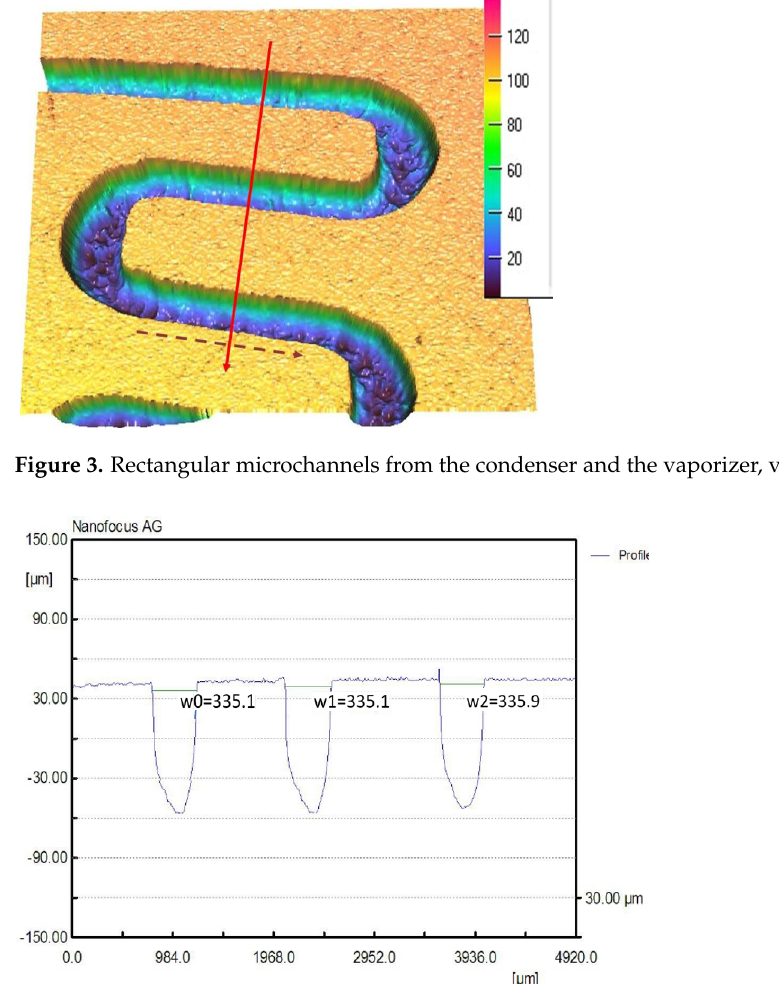
Figure 4. Transverse 2D profile and dimensions of the rectangular microchannels, obtained by laser profilometry.